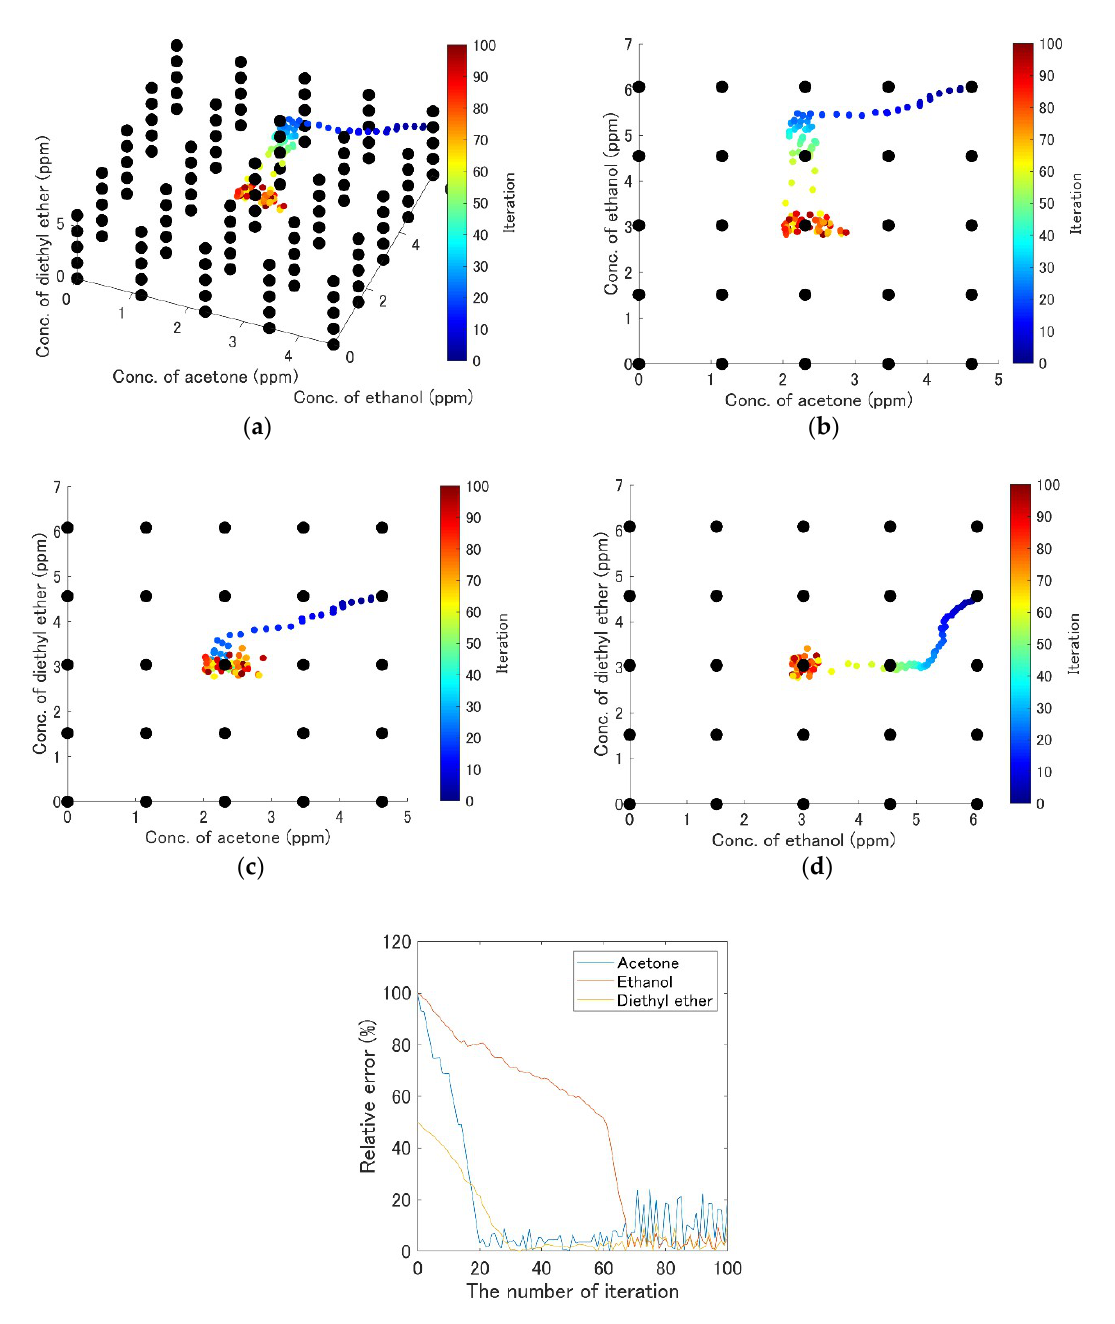
Figure 7. Contour maps of the error hypersurfaces obtained from all the measurement data. The concentration of acetone was fixed to prepare the contour maps. ( a ) 0 ppm, ( b ) 1.2 ppm, ( c ) 2.3 ppm,